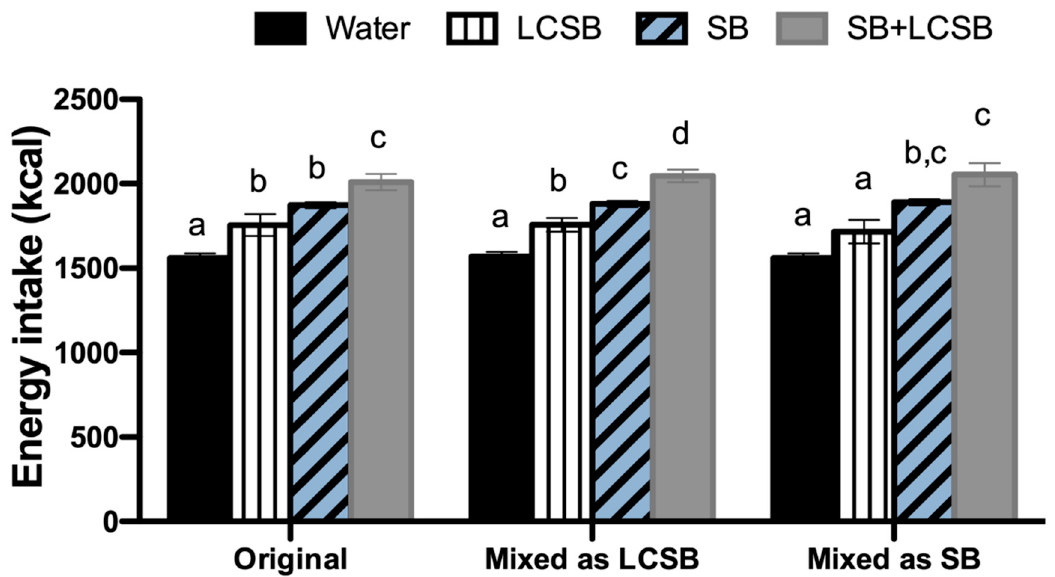
Figure 1. Energy intake after adjustment for age, sex, race/ethnicity, income, physical activity, and BMI percentile in original analysis [7] and re-analyses in which mixed foodcodes were considered LCSBs or SBs. Bars with different letters are significantly different from one another within their own analysis (i.e., groups were not compared across analyses).